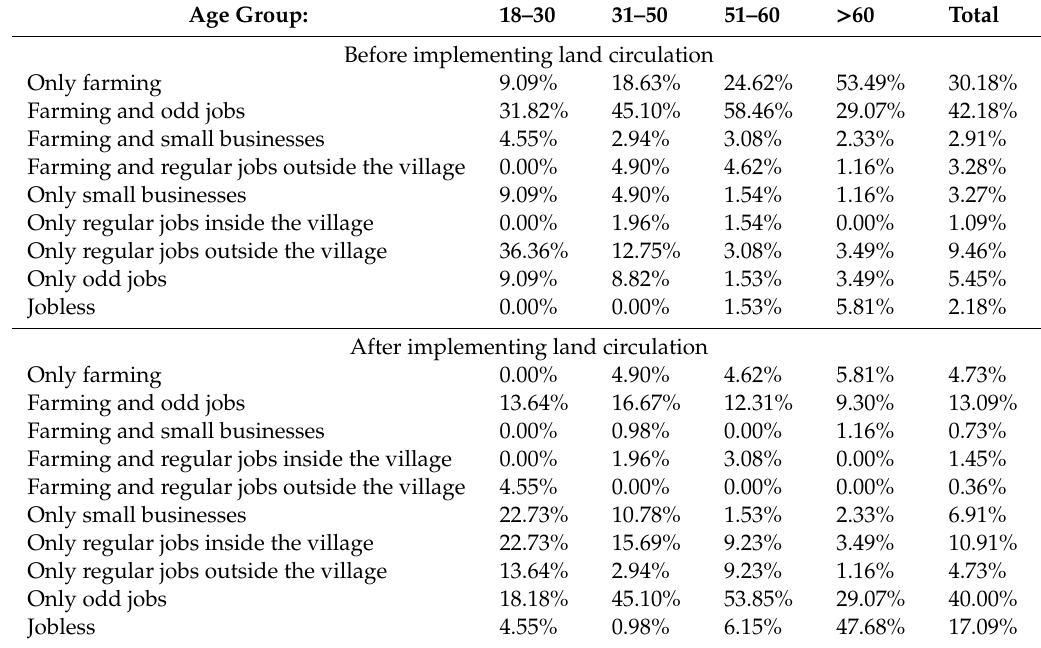
Table 2. Household occupation